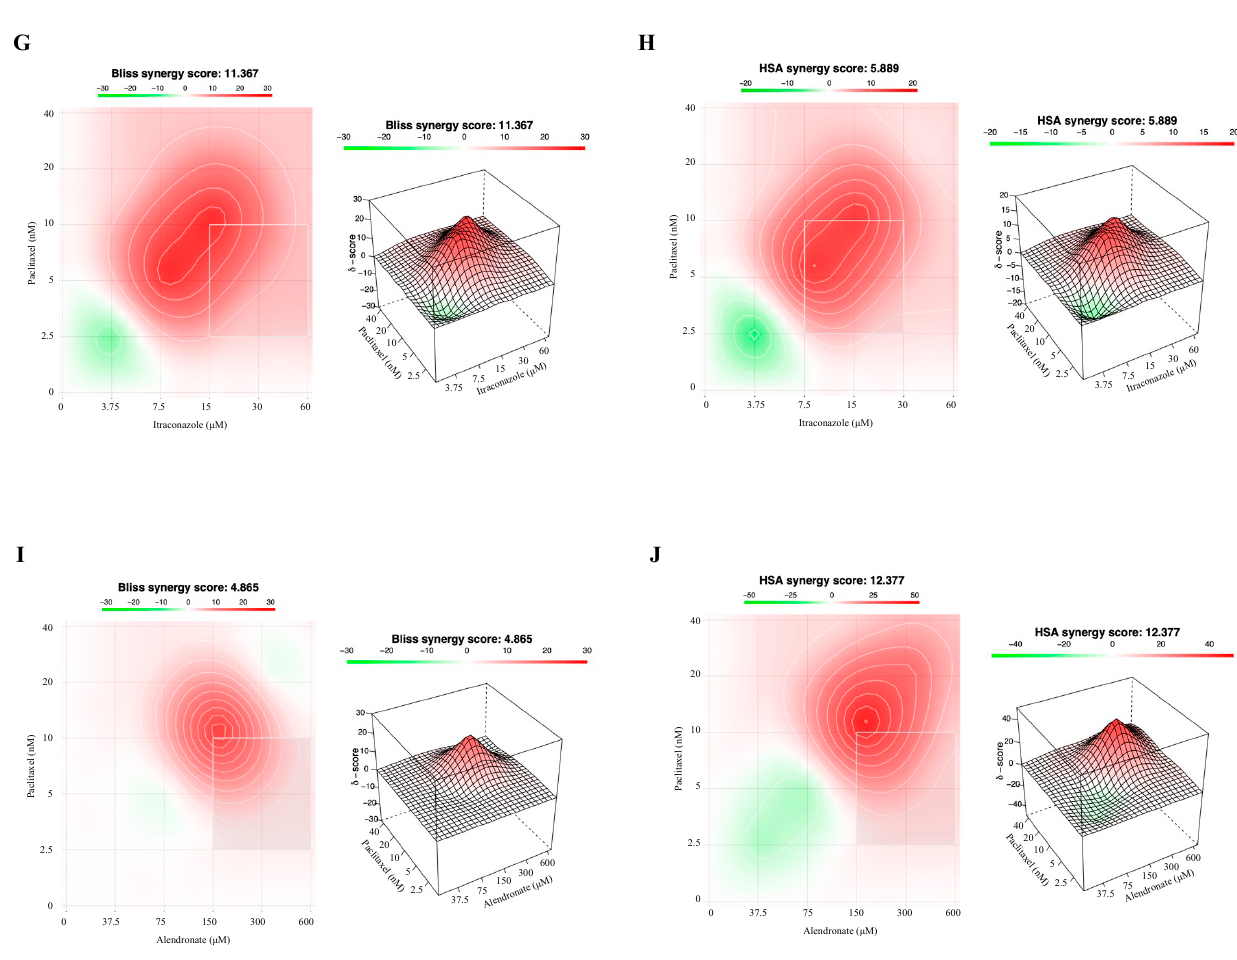
Figure 5. Combining Paclitaxel with repurposed drugs has a synergistic effect on OVCAR8. ( A – J ) Bliss Independence and High Single Agent synergy 2D and 3D plots showing drug synergism of OVCAR8 cells, after exposure to a fixed-dose ratio that corresponds to 0.25, 0.5, 1, 2 and 4 times the individual IC 50 values for each drug, e.g., Paclitaxel combined with ( A , B ) Pitavastatin, ( C , D ) Metformin, ( E , F ) Ivermectin, ( G , H ) Itraconazole and ( I , J ) Alendronate for 48 h. The combined treatment was co ‐ administered at the same time. All assays were performed in triplicate in at least three independent experiments. Synergy score: <10 (antagonism, green), =1 (additivity, white) and >10 (synergism, red).